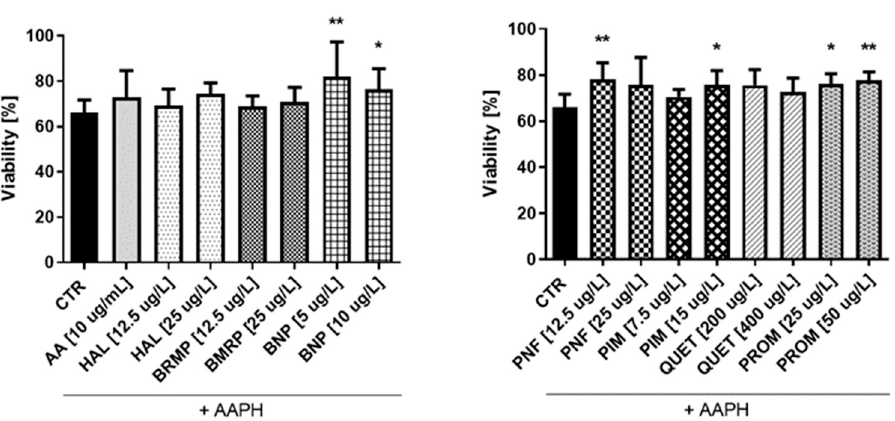
Figure 9. Potential antioxidative properties of tested antipsychotic drugs in astrocytes. The measurements of cell viability were assessed using a WST-1 assay. The cells were stimulated for 1 h with the tested compounds, and later AAPH, an oxidative stress inducer, was added. The results are presented relative to control treated with pure medium (100% viability). Calculations show a statistically significant difference between the control (CTR, comprising cells treated with pure AAPH [15 mmol/L]) and samples co-treated with antipsychotics and AAPH; * p < 0.05, ** p < 0.01 vs. control (samples with AAPH).